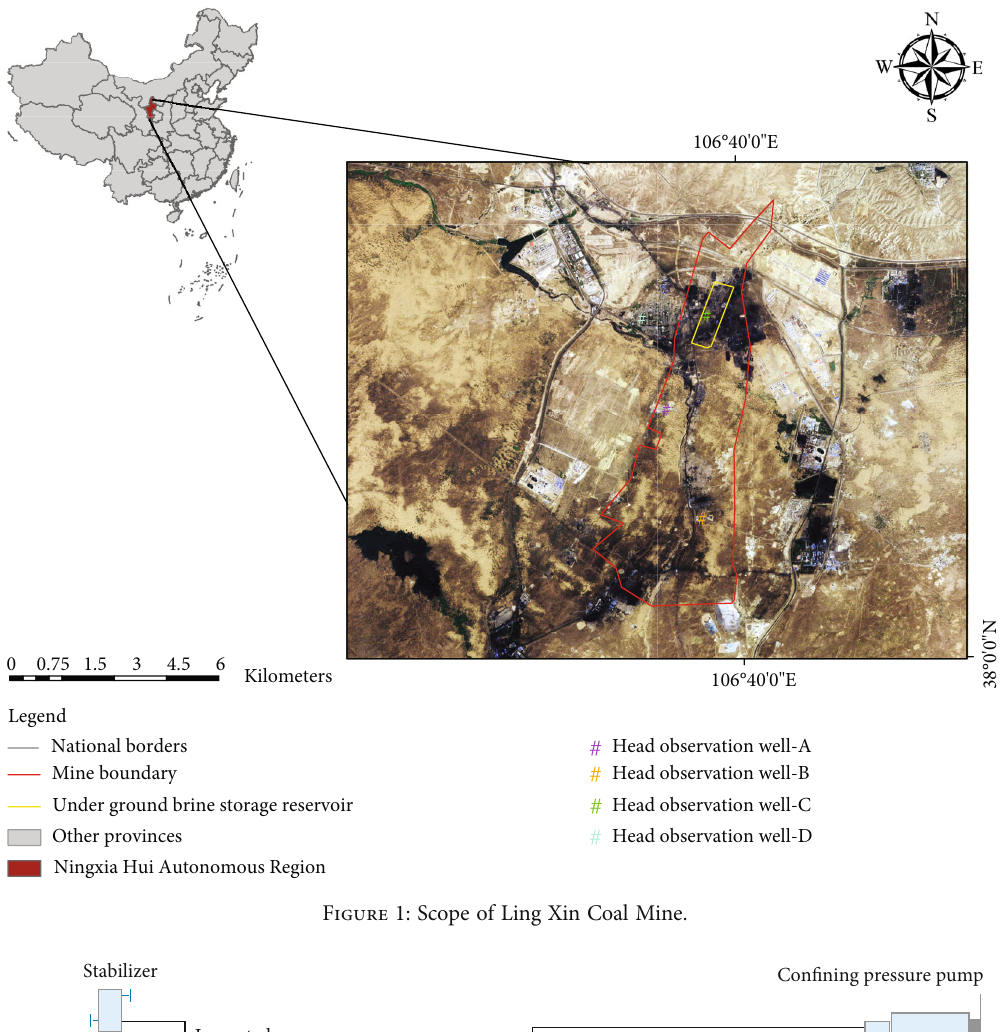
Figure 1: Scope of Ling Xin Coal Mine.